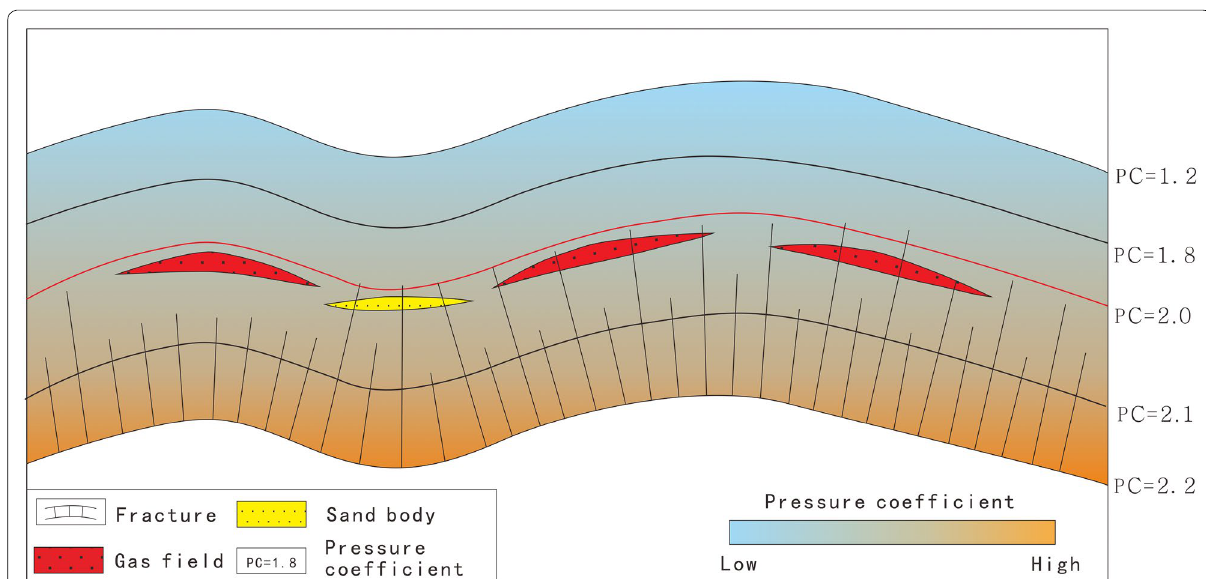
Fig. 10 Fractures induced by overpressure and litho-stratigraphic traps in the Ledong and Lingshui sags, Qiongdongnan Basin